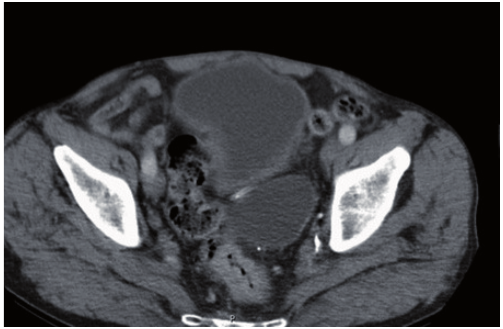
Figure 2: CT scan of a patient with obstructing carcinoma of the rectum.